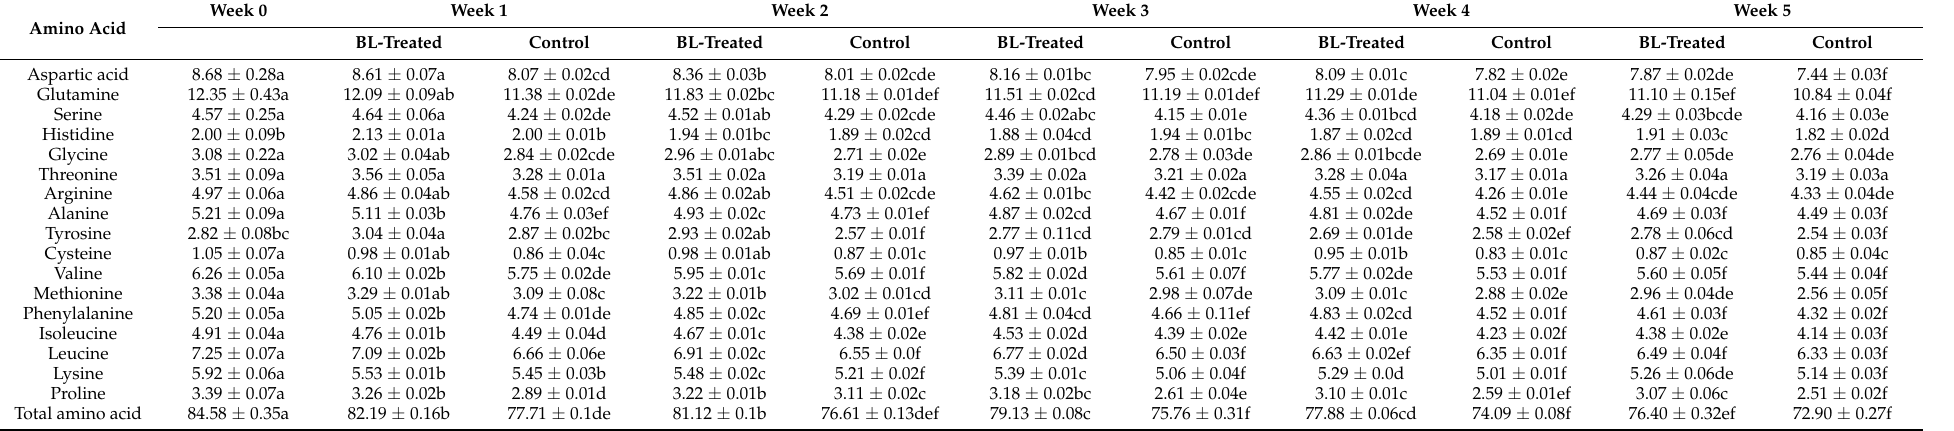
Table 2. Effects of BL-treated eggs on amino acid composition (g/100 g) of freeze-dried albumen during 5 weeks of storage. Amino Acid Aspartic